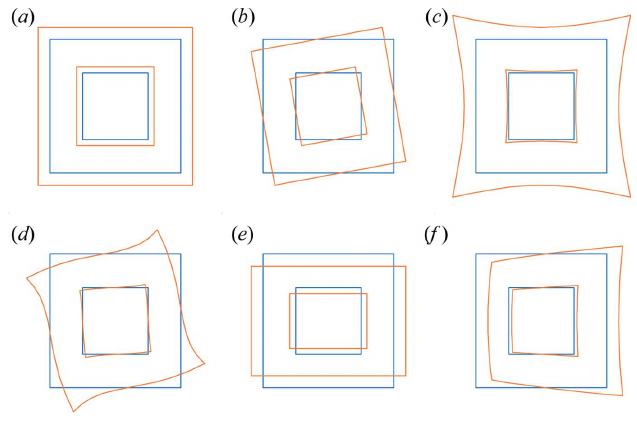
Figure 2 Distortions present in static beam electron diffraction data (blue denotes the undistorted pattern and orange the distorted pattern). ( a ) Magnification error, ( b ) in-plane rotation, ( c ) barrel-pincushion distor- tion, ( d ) spiral distortion, ( e ) elliptical distortion and ( f ) parabolic